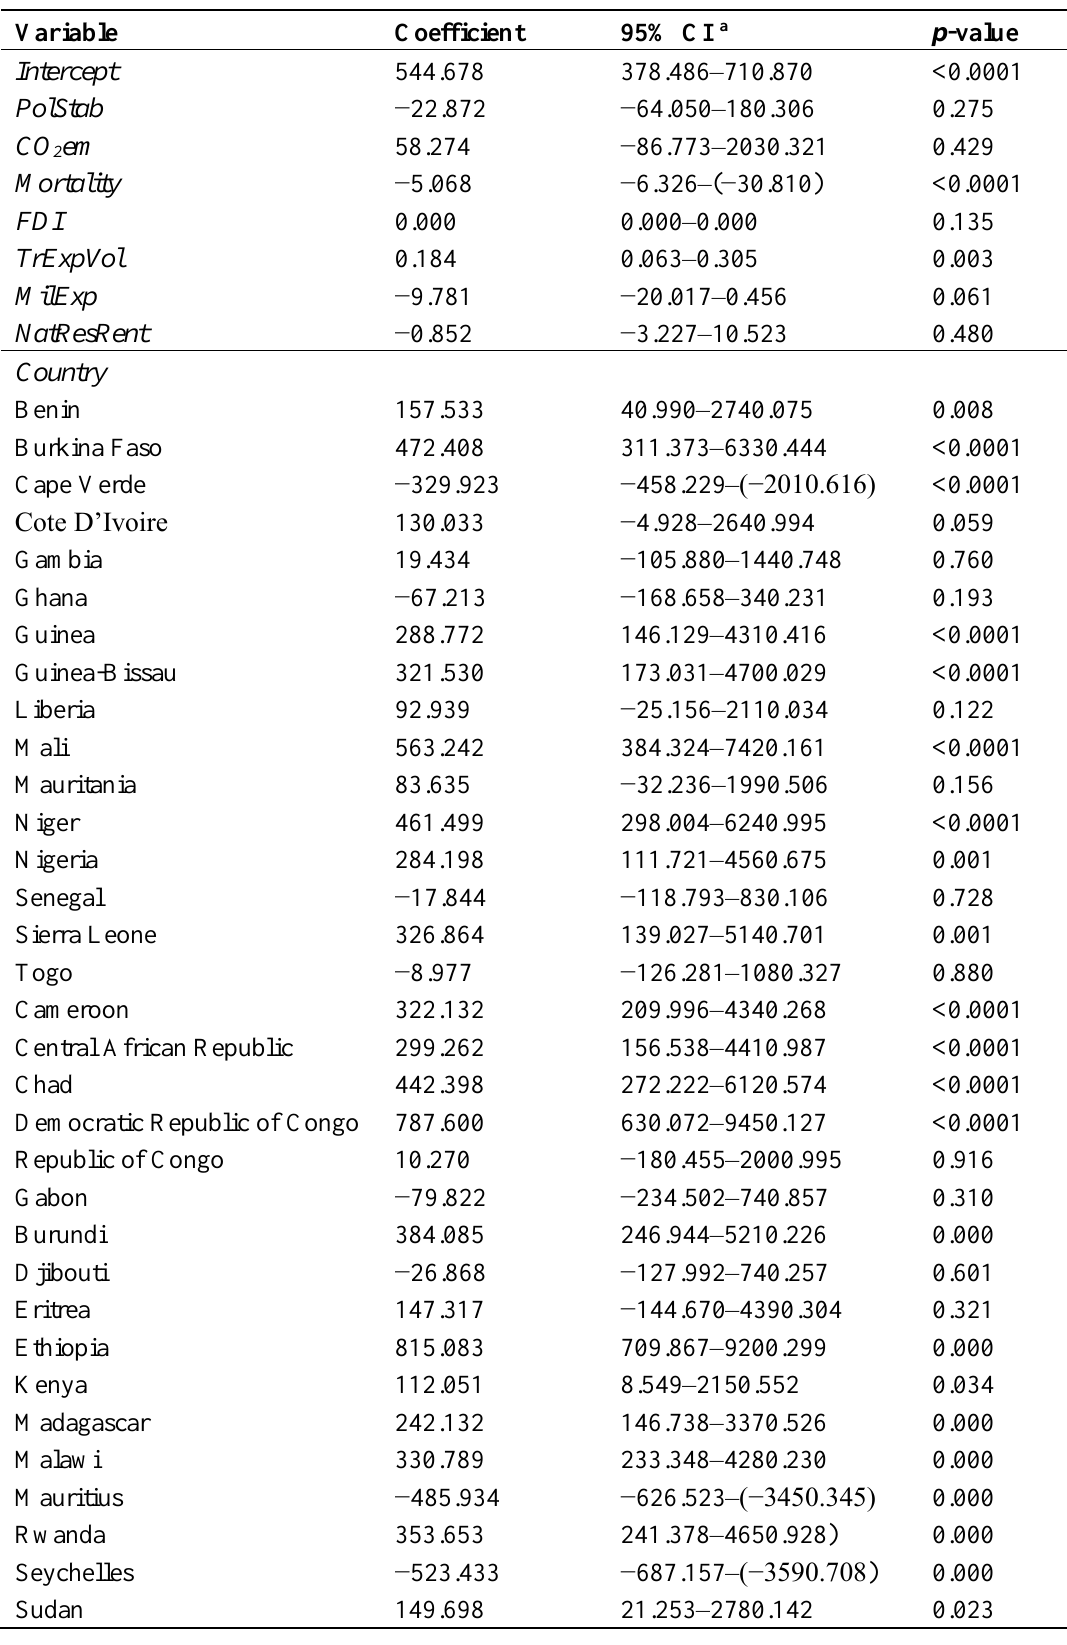
Table 2. Overall regression results. Dependent variable: aid flows. PolStab, political stability; CO em, CO emissions; TrExpVol, trade export volume; MilExp, military 2 2 expenditure; NatResRent, natural resource